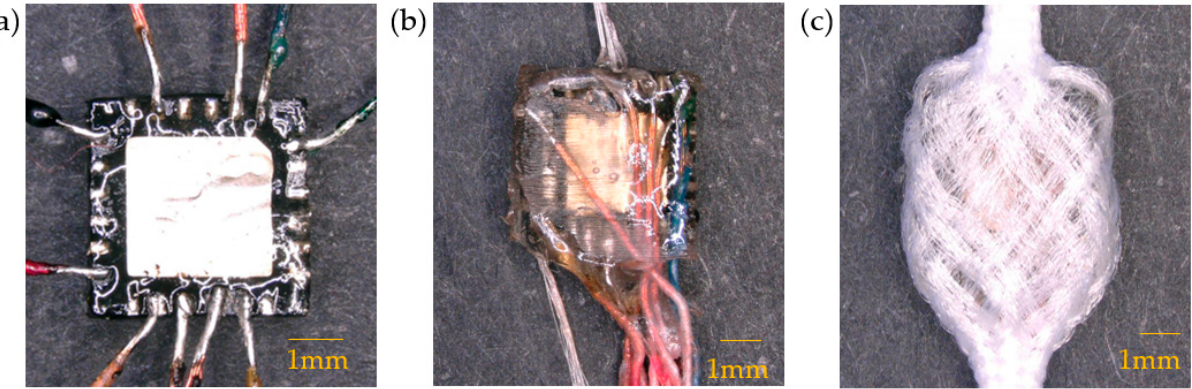
Figure 1. The IMU E ‐ yarn. ( a ) The soldered stage of the E ‐ yarn. ( b ) The second stage of the E ‐ yarn, encapsulated with an added Vectran™. ( c ) The final stage of the E ‐ yarn, showing the braided